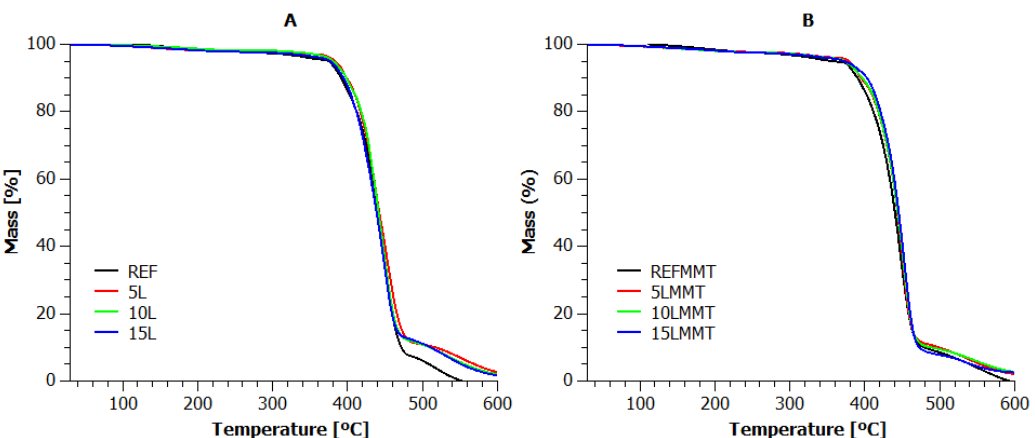
Figure 2. Thermograms of the materials with 5, 10, and 15 triple layers, deposited on the surface of ( A ) the PA6 and ( B ) the PA6/MMT nanocomposites.